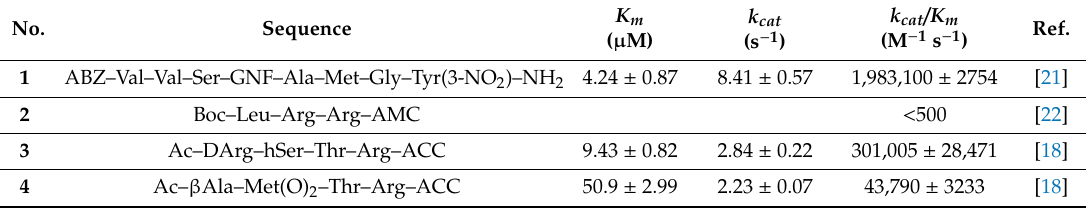
Figure 6. Kinetic curves for the 20S proteasome in two systems: ( A ) substrate alone and ( B ) in the presence of the artificial activator, 0.01% sodium dodecyl sulfate (SDS). Table 1. Overview of the fluorogenic substrates of the trypsin-like subunit of the 20S proteasome.